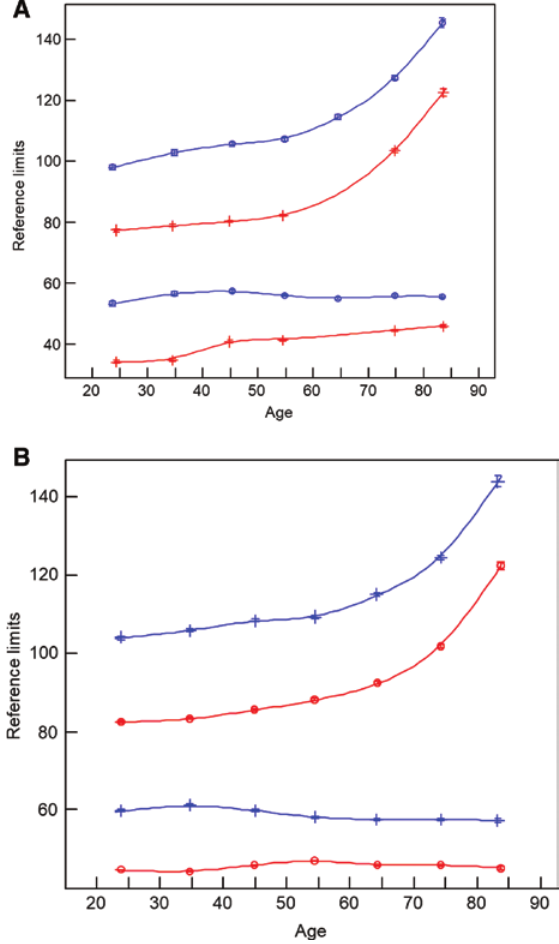
Figure 3: Reference limits of serum creatinine ( μ mol/L) depending on age (years) separated by sex. Lower lines represent the 2.5 th percentile, upper lines the 97.5 th percentile, blue lines represent men (n = 386,317) and red lines women (n = 460,846). The data were obtained from two primary health care laboratories (A: laboratory 1, n = 327,132; B: laboratory 2, n =